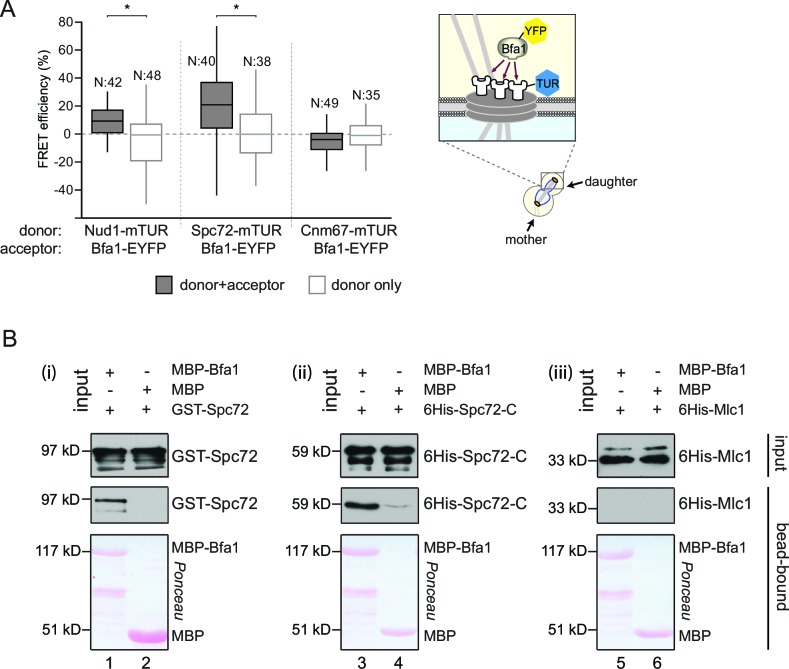
Bfa1 interacts with the SPB outer layer proteins Spc72 and Nud1.(A) Box-whisker plots representing the distributions of FRET efficiency values for Bfa1 (C-terminally tagged with EYFP) in pair with Nud1, Spc72 or Cnm67 (C-terminally tagged with mTUR) measured at the dSPB as depicted in the cartoon. The FRET data shown here and in subsequent figures are one out of two biological replicates unless otherwise specified. For Box-Whisker plots representing FRET data, the boxes show the lower and upper quartiles, the whiskers show the minimum and maximal values excluding outliers; outliers (not shown) were calculated as values greater or lower than 1.5 times the interquartile range; the line inside the box indicates the median. N is the sample size; asterisks show significant difference according to student’s t-test (p<0.01) and the exact p-values are indicated in the accompanying data file (Figure 1—source data 1). (B) In vitro binding assay of bead bound recombinant MBP-Bfa1 with bacterially purified GST-Spc72 (i), 6His-Spc72-C (codons 231–622) (ii) and 6His-Mlc1 (iii). MBP on beads and 6His-Mlc1 were used as negative controls for in vitro binding reaction. Spc72 was detected with anti-GST antibody; Spc72-C and Mlc1 were detected with anti-6His antibodies after immunoblotting. The Ponceau S stained membrane shows the levels of MBP-Bfa1 and MBP used in the assay. One representative blot out of two independent experiments is shown in each panel.DOI:
http://dx.doi.org/10.7554/eLife.14029.00310.7554/eLife.14029.004Figure 1—source data 1.Raw data and the calculated FRET efficiencies of Nud1-Bfa1 and Spc72-Bfa1 pairs at SPBs in cycling cells (source data for Figure 1A).